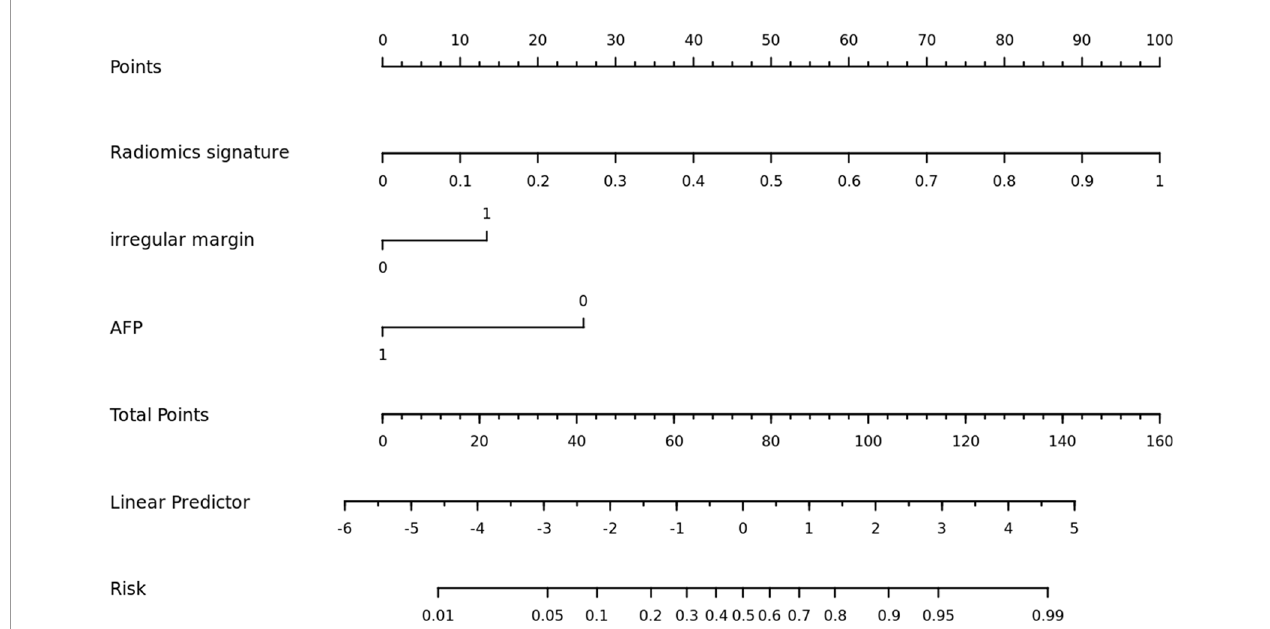
FIGURE 4 | The nomogram was built using a combination model that included radiomics signature, irregular margin, and serum AFP